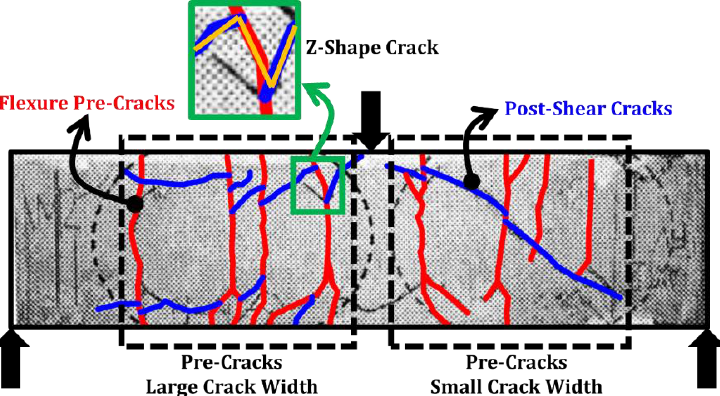
Figure 13. Pre-cracks stopping mechanism for RC beams.